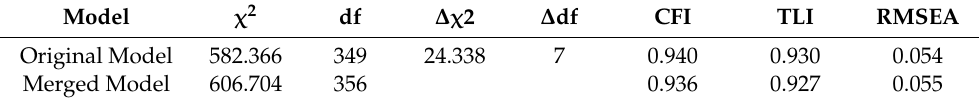
Table 4. Discriminant validity testing using the method proposed by Bagozzi and Yi.